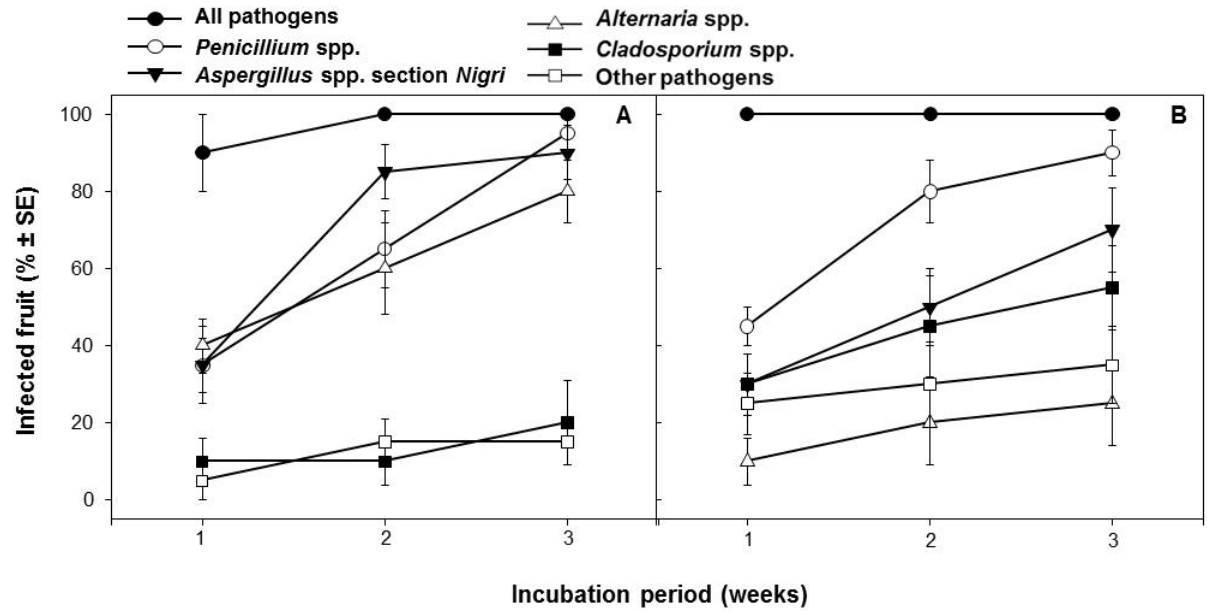
Figure 2 . Incidence of postharvest fungal diseases from latent (A) and wound (B) infections on ‘Medjool’ dates from Elx (Spain). Date fruits were surface-disinfected (A) or artificially wounded (B) and incubated at 20ºC in humid chambers for 3